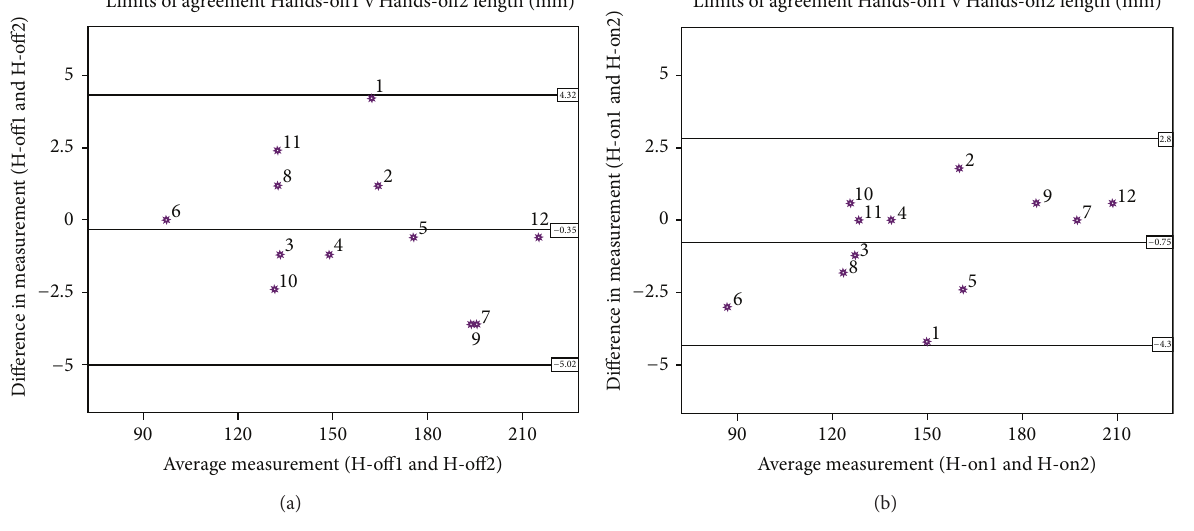
Figure 5: Bland and Altman plot for intra cast length of both Hands-off (a) and Hands-on (b) castings. Table 3: Mean, standard deviation of the residual limb length and volume for each repetition of casting concepts, intra cast mean difference, and the ICC